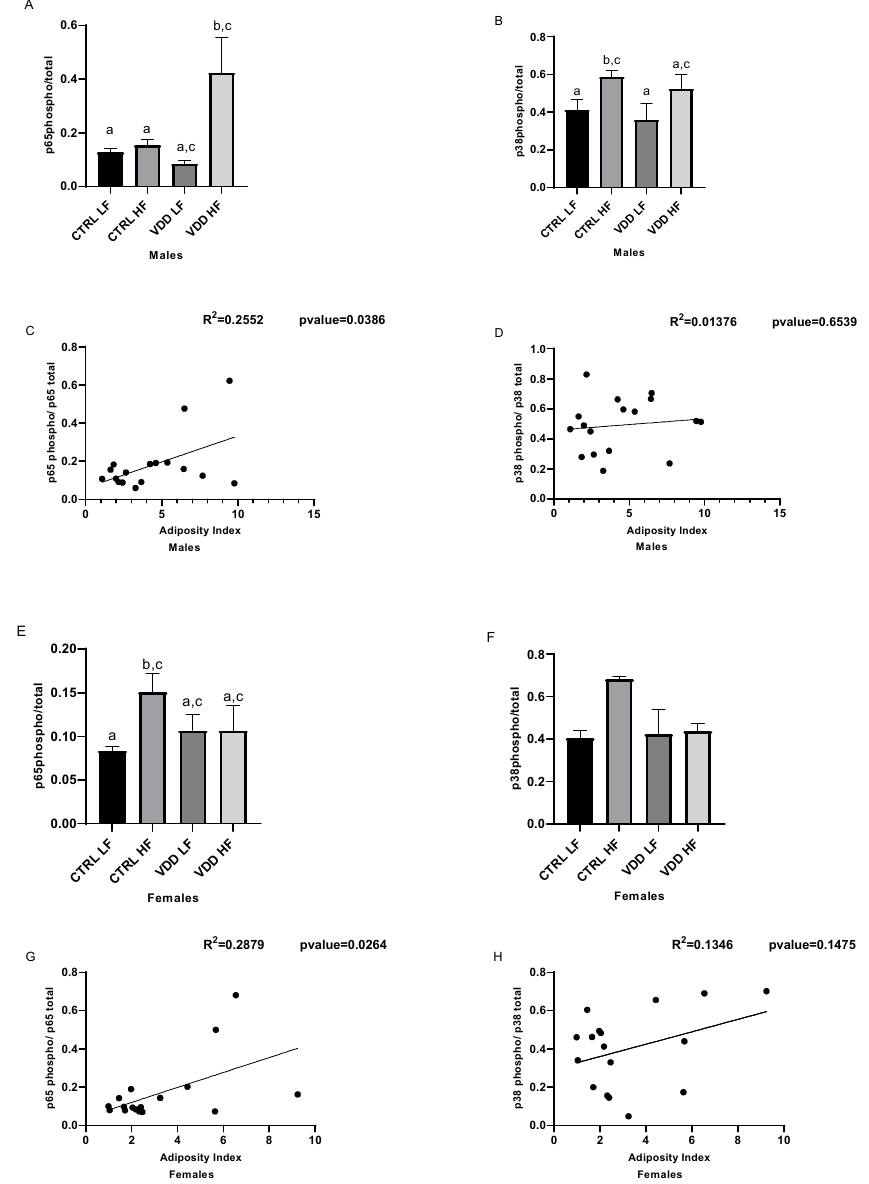
Figure 4. Phosphorylation levels of the NF-kB (p65) and p38 in adipose tissue of the offspring. Phosphorylation levels of p65 and p38 were evaluated using ELISA in males ( A , B ) and females ( E , F ). The data are expressed as relative expression ratios (p65phosphorylated/p65total and p38 phos- phorylated/p38total). Values are presented as mean ± SEM. Bars not sharing the same letter were significantly different in Fisher’s LSD post hoc test. p < 0.05. Scatter plot of the correlation between adiposity p65 in males ( C ) and females ( G ), and scatter plot of the correlation between adiposity and p38 in males ( D ) and females ( H ), using Pearson r correlation, p < 0.05 indicated that positive correlation was significant.